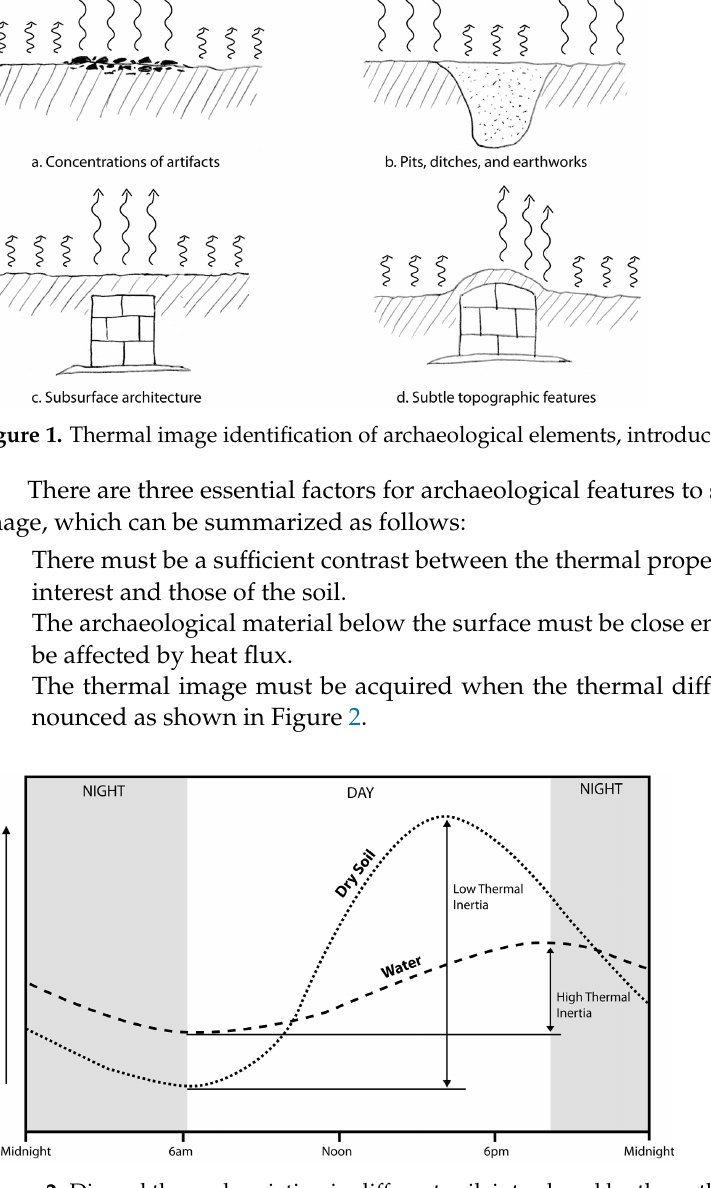
Figure 2. Diurnal thermal variation in different soil, introduced by the authors in